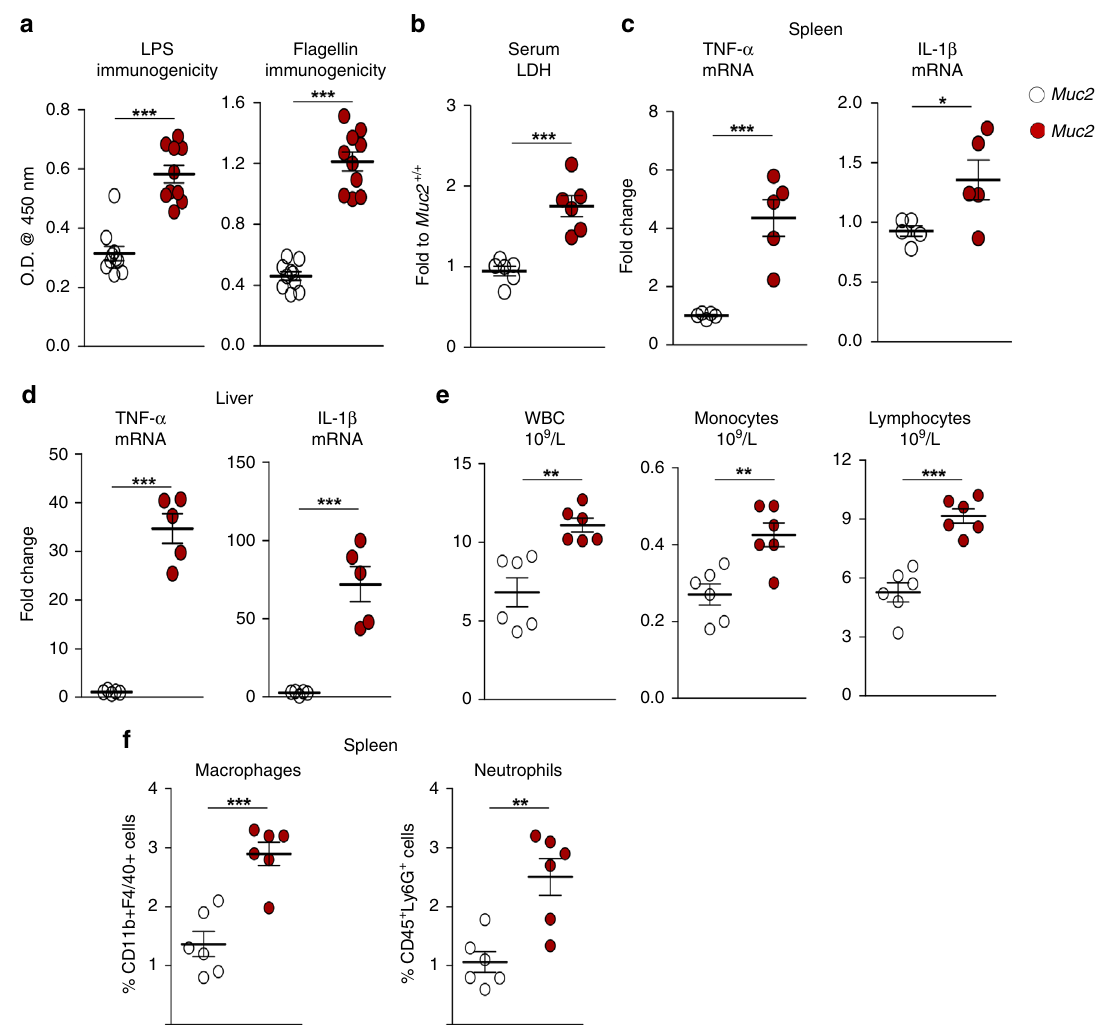
Fig. 1 Muc2 − / − littermates exhibit basal systemic in fl ammation. a Determination of antibodies against LPS and fl agellin in the sera of Muc2 − / − littermates by ELISA ( n = 10). Representative data are from four independent experiments; paired Student ’ s t test. b High basal LDH levels in the circulation con fi rm damage and toxicity of tissue in Muc2 − / − littermates ( n = 6). Representative data from three independent experiments; paired Student ’ s t -test. c , d High pro-in fl ammatory cytokine gene expression in the spleen and liver of Muc2 − / − littermates as determined by real time RT-PCR ( n = 5). Representative data of four experiments; paired Student ’ s t test. e Complete blood count (CBC) analysis showing high levels of WBC, monocytes,